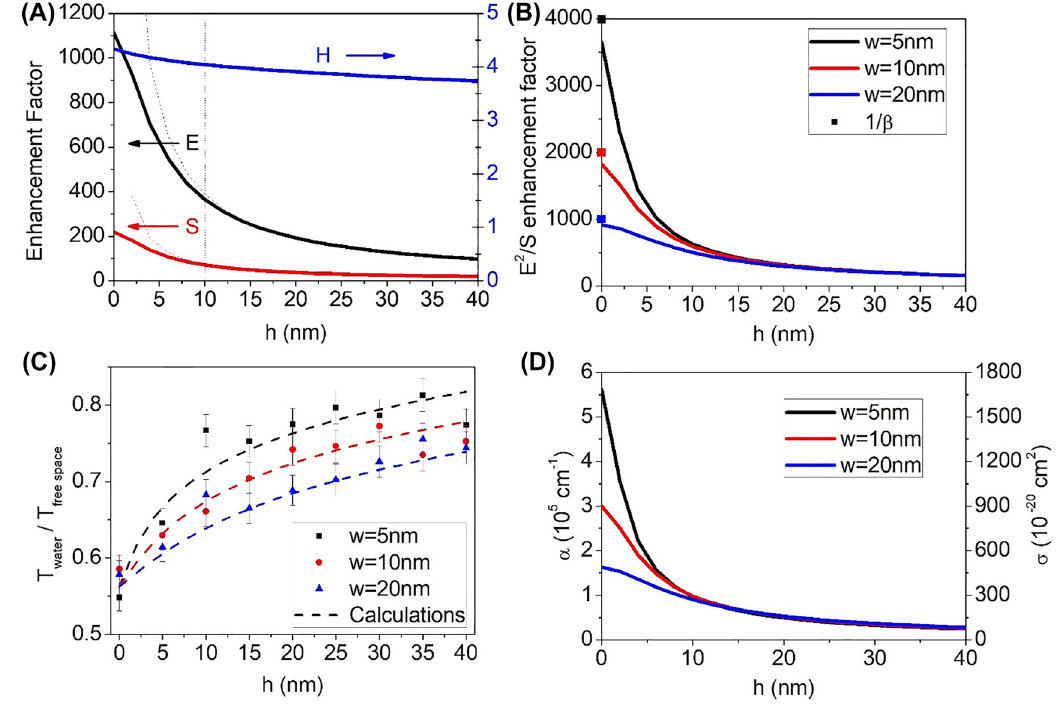
Figure 5: Absorption enhancement on top of nanotrenches at various distances. (A) Electromagnetic field distribution above a 10 nm gap obtained from modal expansion calculation. Dashed curves denote a 1/ h fitting curve, fitting well in radiative zone ( h > w ) but deviating from the calculations in the reactive zone ( h < w ). The dashed vertical line denotes the boundary of radiative zone and reactive zone for the 10 nm gap. (B) Calculated absorption coefficient enhancement above 5, 10, and 20 nm gap samples. Inverse of gap coverage ratio is plotted as a dot in y -axis for comparison. (C) Plots of experimental (dots) and theoretical (dashed lines) transmission ratios for various gap sizes and gap-water distances. Normalized intensity transmission for nanogap with water is divided with that of nanogap without water. The error bars correspond to uncertainties introduced during repeated uses of the cover layer (see Supporting Information for details). (D) Effective absorption coefficient (left axis) and absorption cross section (right axis) of liquid water, corresponding to the transmission decrease shown in Figure